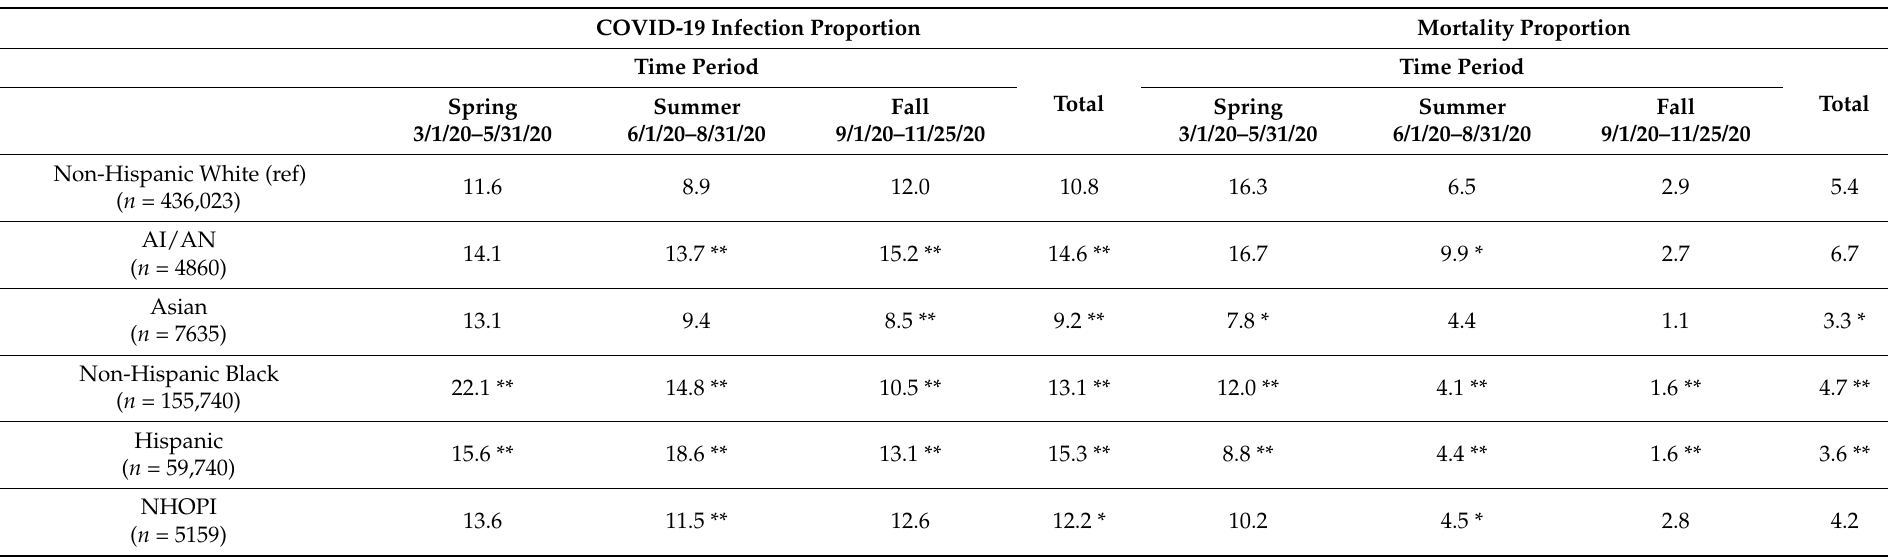
Table 3. Unadjusted COVID-19 infection and mortality proportions by race/ethnicity for each time period from 3/1/2020–11/25/2020. COVID-19 Infection Proportion Mortality